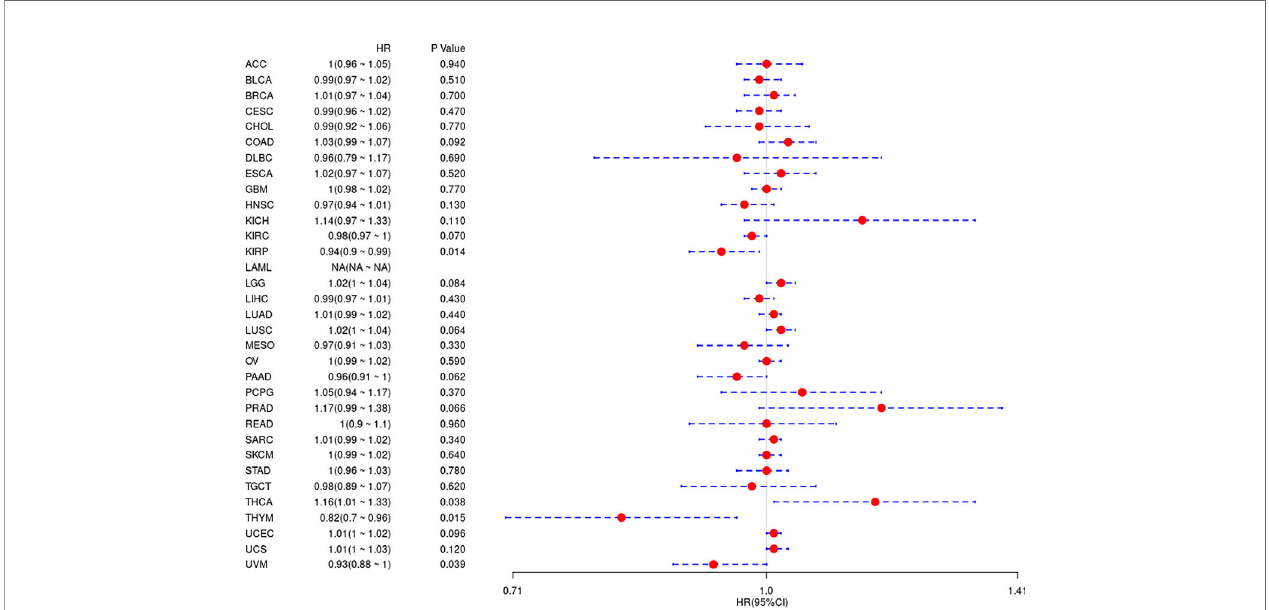
FIGURE 4 | Analysis of the relationship between HDAC6 and DSS in 33 tumors using one-way Cox regression, presented using forest